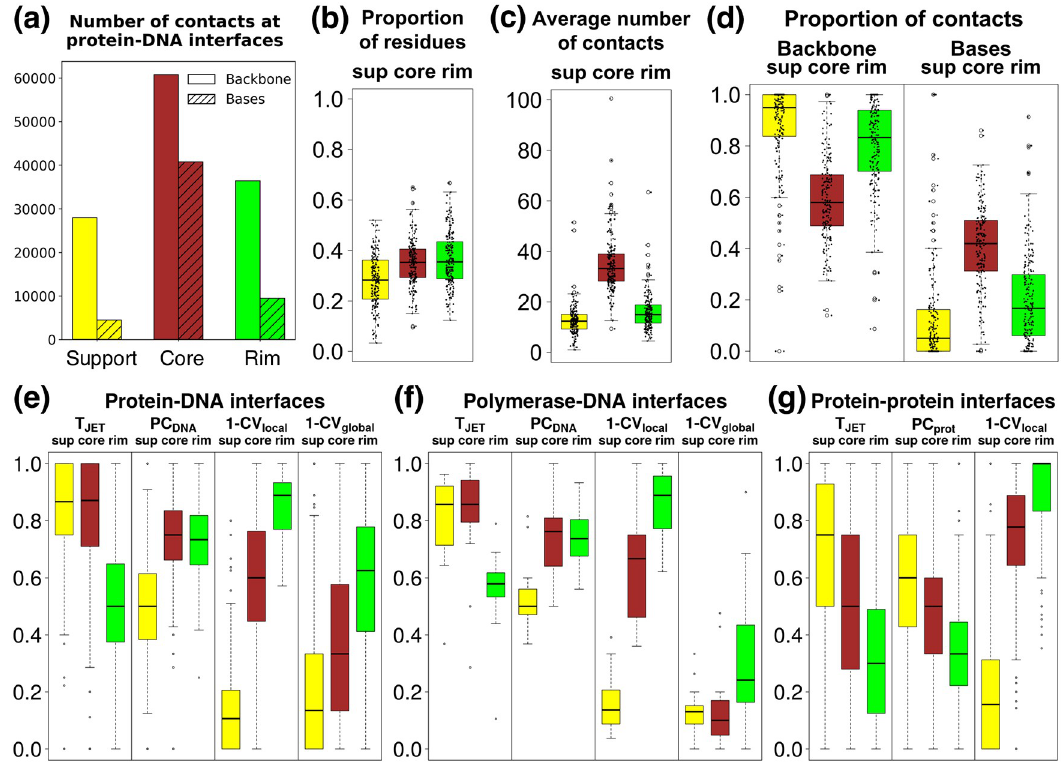
prot : protein-protein interface propensities, CV local and CV global : local and global circular variances computed with a radius of 12 Å and 100 Å , respectively. Distributions are computed on: (e) all protein-DNA interfaces